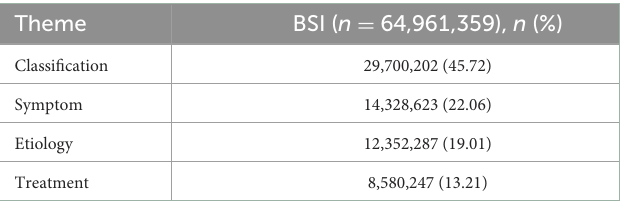
TABLE 1 The BSIs of the total search and four themes of urticaria from October 23, 2017 to April 23,